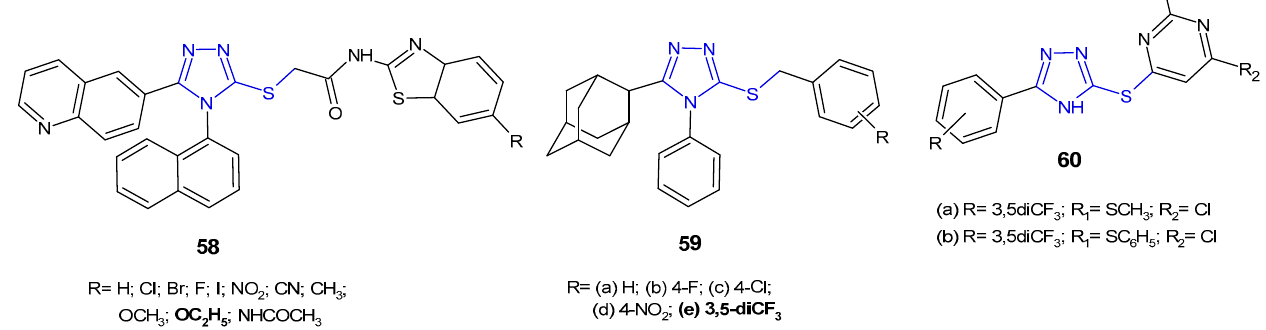
Figure 18. S-substituted 1,2,4-triazole-3-thioles with antibacterial activity-continued. Al-Abdullah et al. (2014) synthesized S -substituted derivatives of 5-(1-adamantyl)-4- phenyl-1,2,4-triazol-3-thiones 59 (Figure 18) and screened their antibacterial activity against a panel of bacterial strains. Among the tested S -substituted derivatives, optimal activity was shown by the 3,5-trifluormethyl benzyl analogue 59e , being 4- to 8-fold higher against S. aureus , B. subtilis , and P. aeruginosa than in the case of ampicillin and gentamicin, and the activity against M. luteus and E. coli was comparable to the reference drugs [63]. Cui et al. (2016) designed a series of 1,2,4-triazole-pyrimidine derivatives linked by